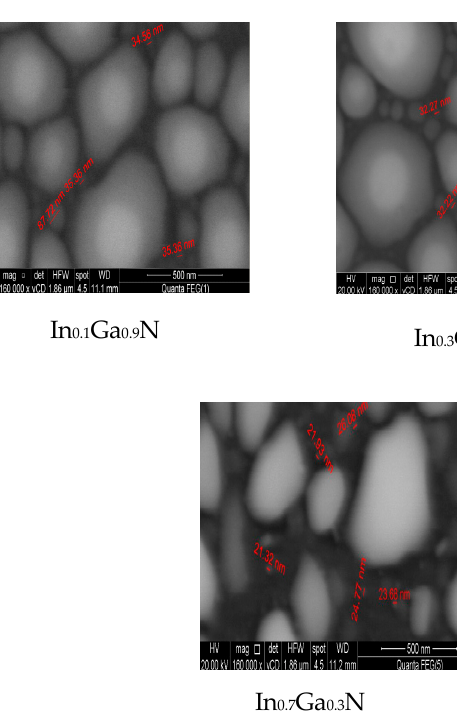
Figure 6. FESEM for In x Ga 1-x N thin films prepared with TVE for the alloy prepared at 950 °C.